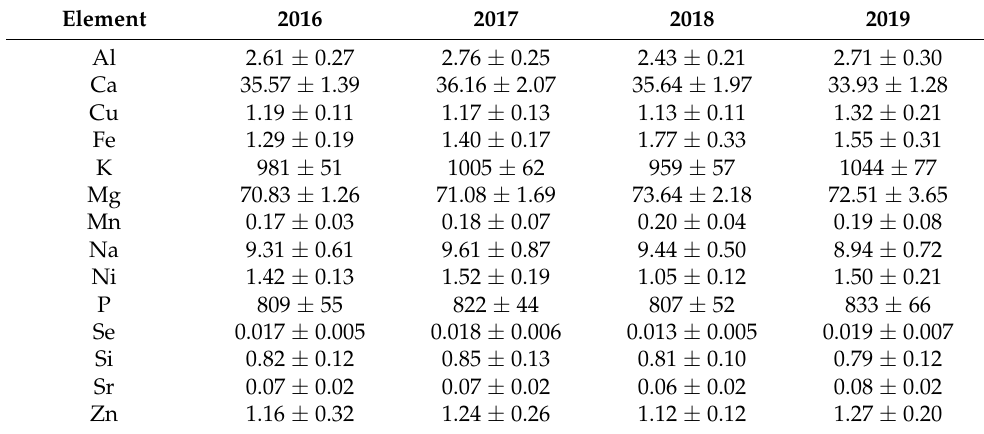
Table 7. Concentrations of some elements (mg/100 g, on flour dry matter basis) * in horse chestnut ashes from AHH semen, harvested in different years.